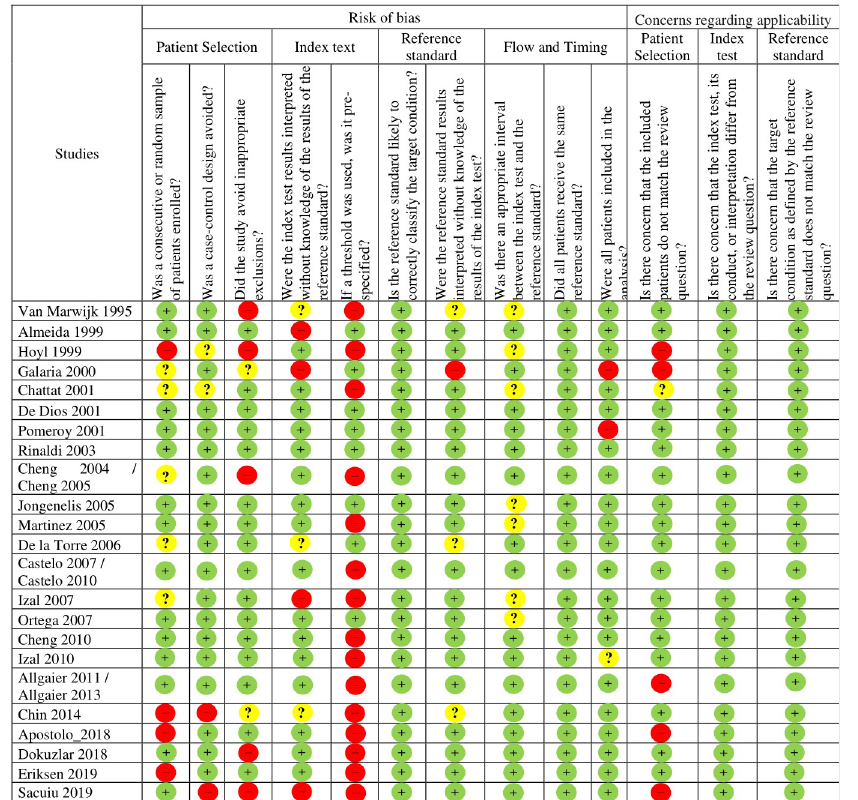
Fig 2. Quality assessment using the QUADAS-2